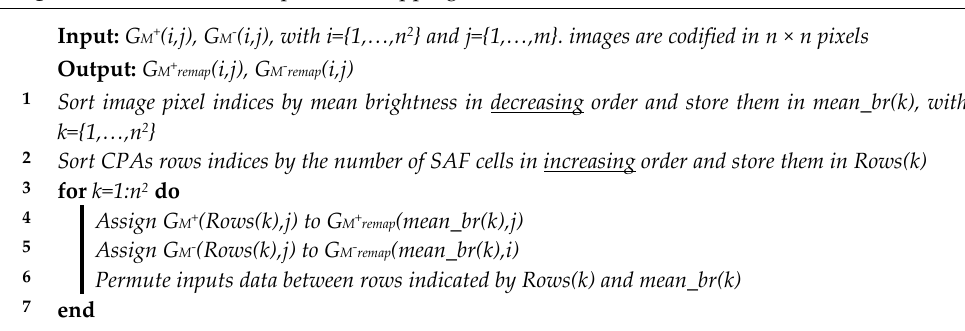
Algorithm 3: Mean-bias-dependent mapping